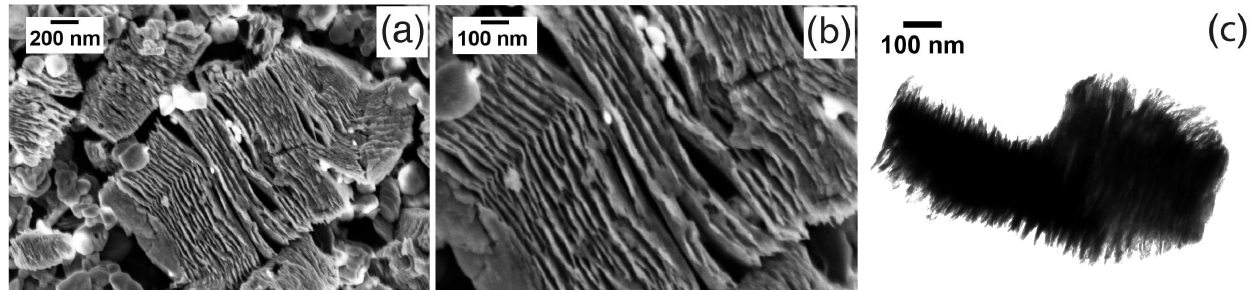
Figure 2. SEM ( a , b ) and TEM ( c ) microphotographs of V 2 CT x MXene powder.